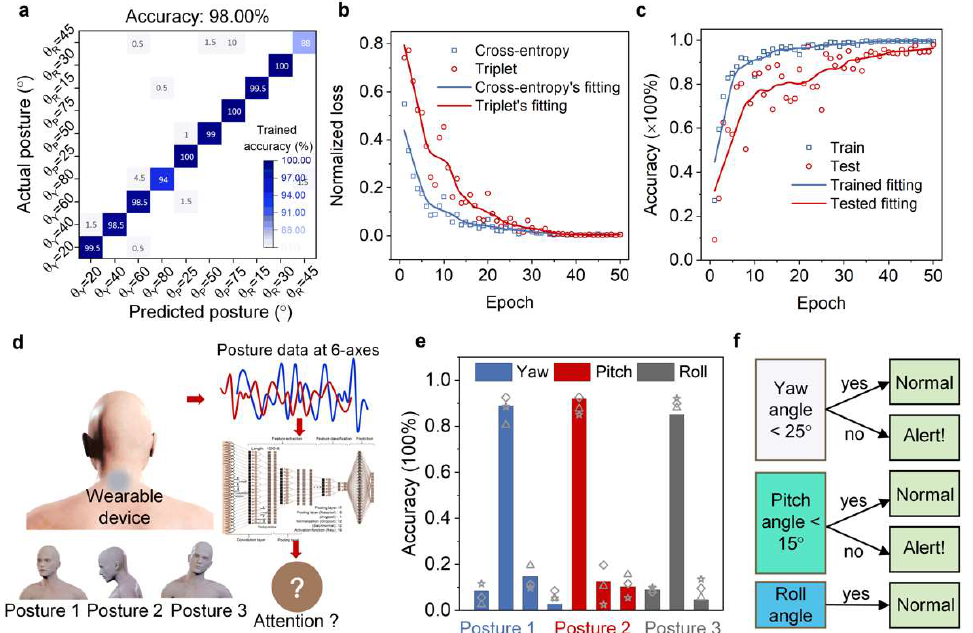
Figure 5. Applications of learning attention through head posture prediction. ( a ) Confusion matrix of real and predicted results under different head postures. ( b ) Trained and tested accuracy during deep learning. ( c ) Normalized loss results of the Ce and Tri function used for feature extractions and classifications. ( d ) Attention assessment block diagram for three new postures. ( e ) Attention- tested accuracy results of three different postures. ( f ) Presupposed attention assessment based on pose angles.